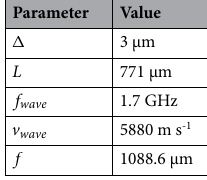
Table 3. Summary of parameter